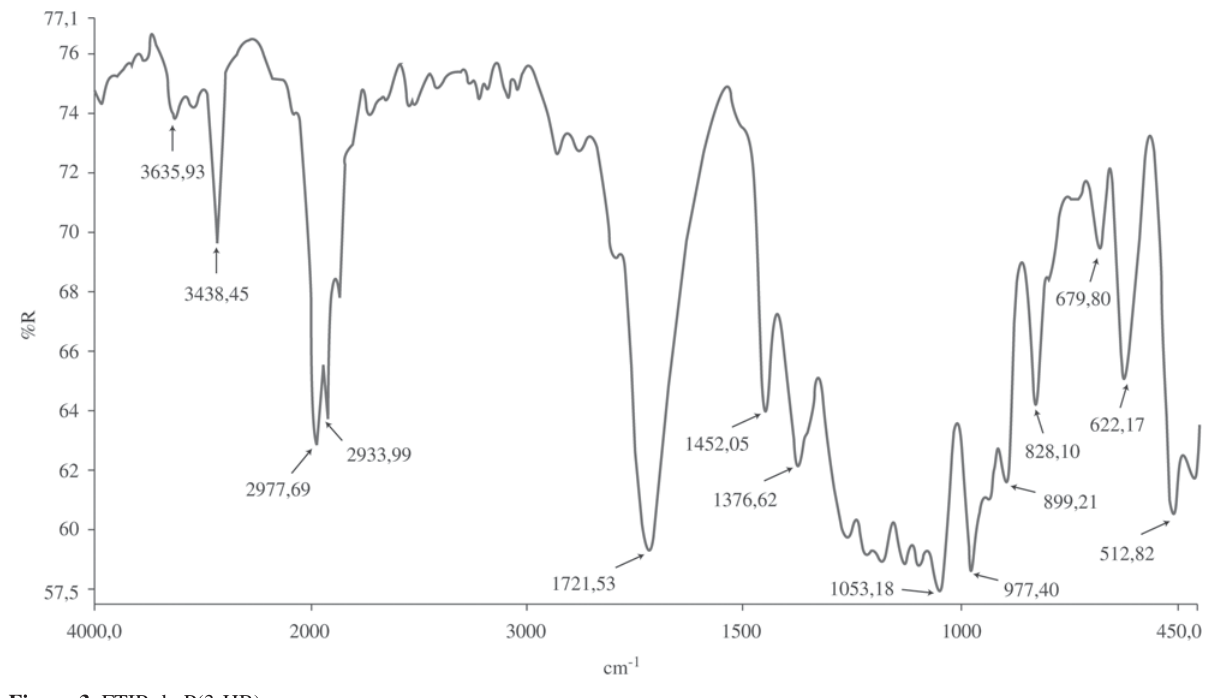
Figura 3. FTIR do